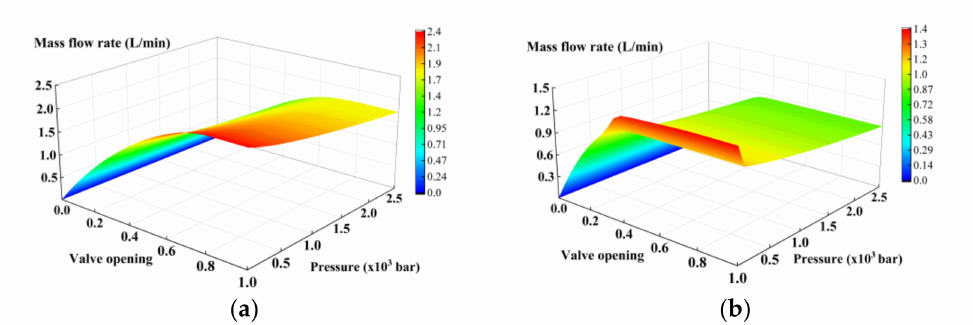
Figure 12. Fuel supply characteristics data of the pump under different speeds: ( a ) 500 r/min; ( b ) 250